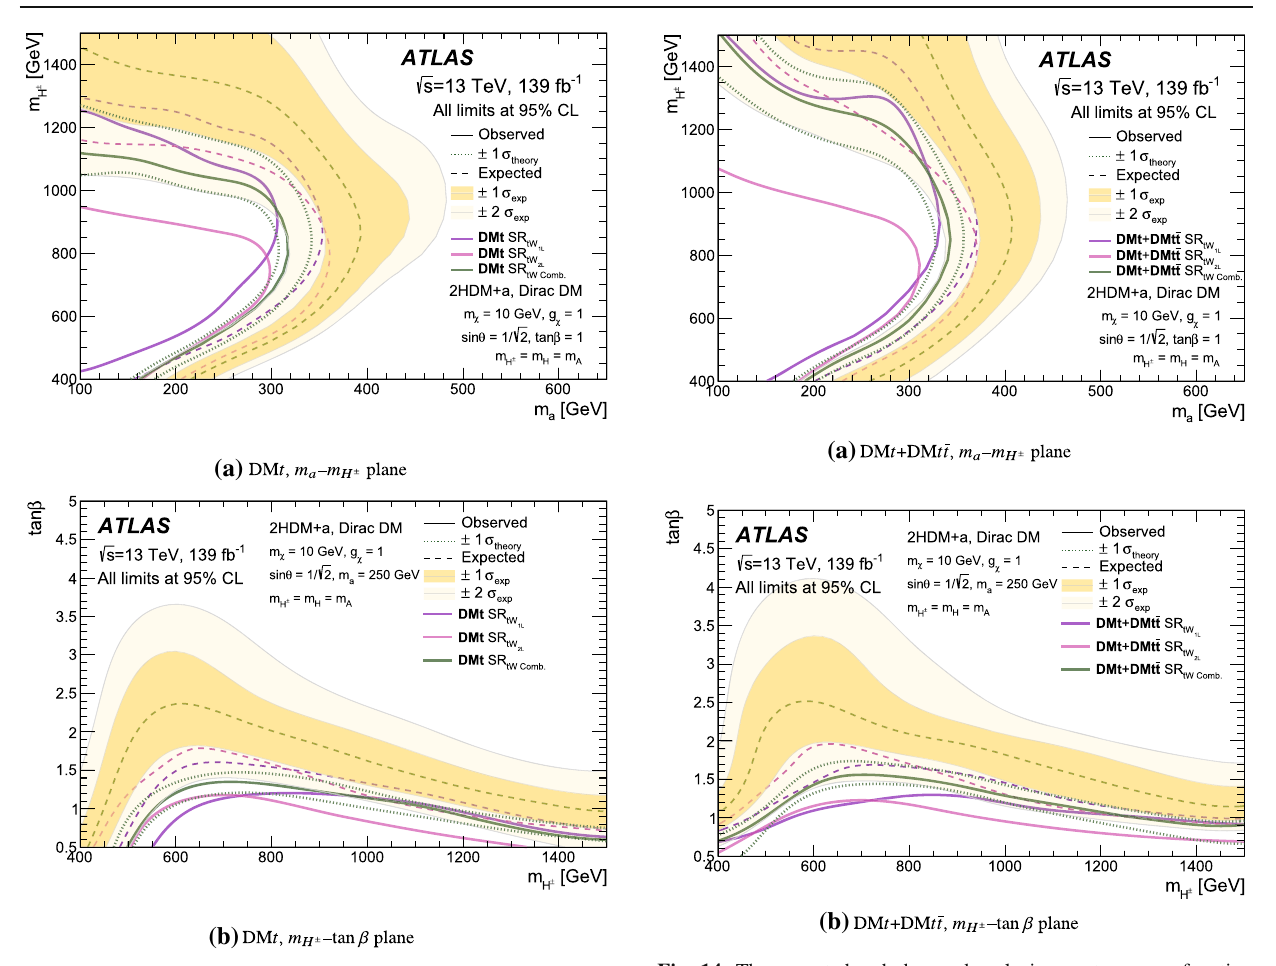
Fig. 13 Theexpectedandobservedexclusioncontoursasafunctionof ( m , m ) (top) and ( m , tan β) (bottom), assuming only tW +DM a H ± H ± contributions, for the individual tW 1L (purple line) and tW 2L (pink line)analysischannels,andfortheirstatisticalcombination(greenline). Experimental and theoretical systematic uncertainties, as described in Sect. 6, are applied to background and signal samples and illustrated by the ± 1 standard-deviation and ± 2 standard-deviation yellow bands and the green dotted contour lines, respectively, for the statistical com- bination